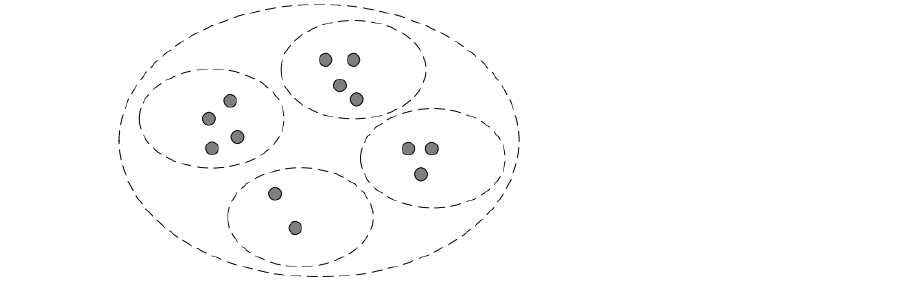
Figure 3. The structure of single-level ENRS. The grey points represent network nodes. The small dotted oval represents domains of ENRS, and the big dotted oval represents the domain of GNRS.